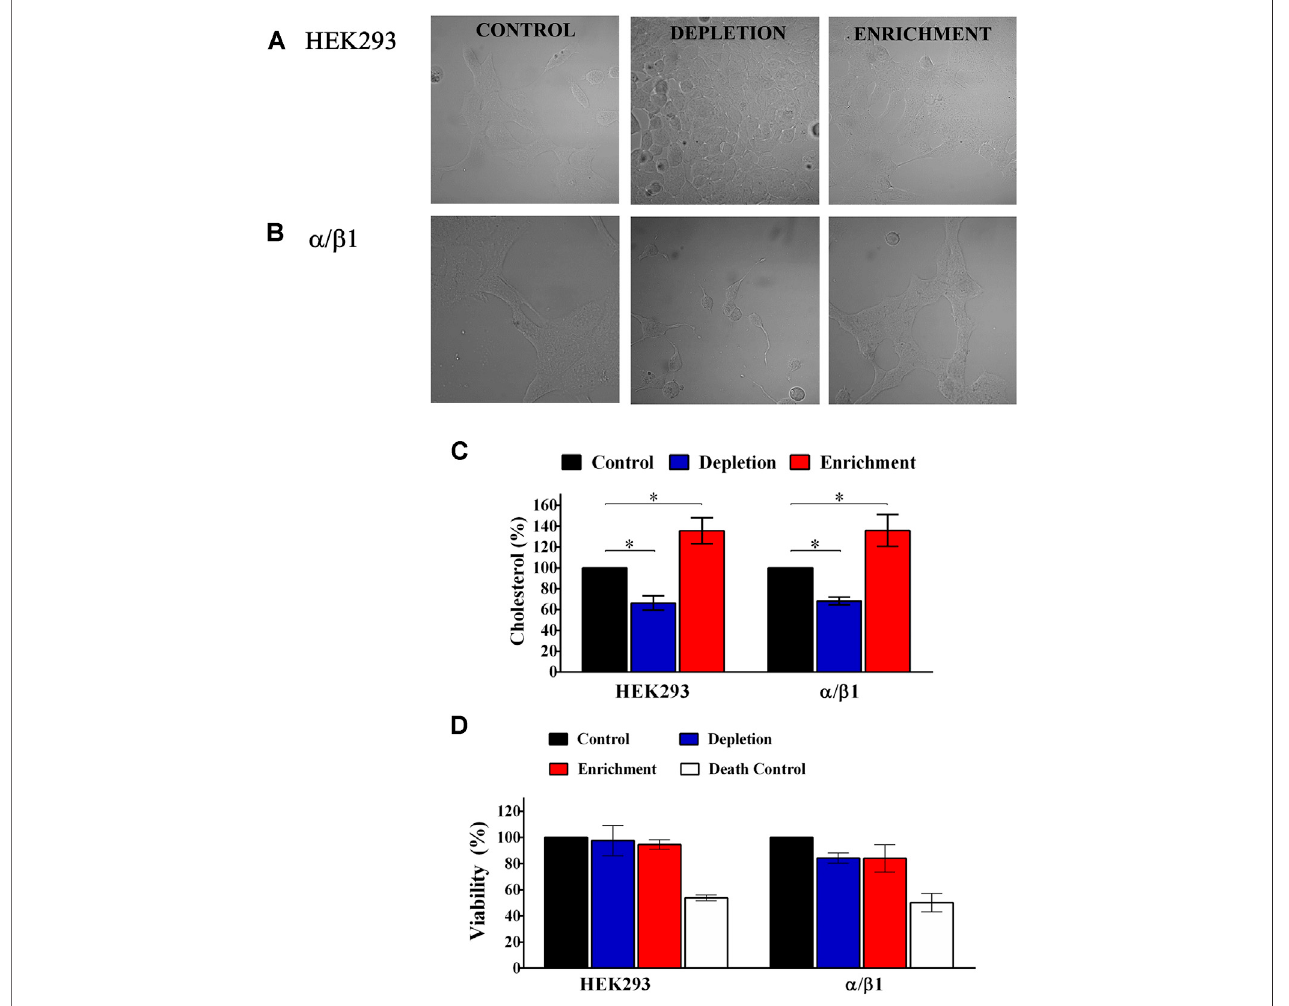
FIGURE 1 | Cholesterol quanti fi cation and cell viability of HEK293 control and cells transfected with BK subunits. (A) HEK293 cells without transfection. (B) HEK293cellstransfected with α + β 1.Leftpanel,controlwithouttreatment.Middlepanel,Cellstreatedwith5 mM ofM β CD.Rightpanel, cellstreatedwith5 mMofCHO- M β CD complex. (C) Results for each treatment with M β CD or M β CD-CLR were normalized using the amount of cholesterol contained in cells without treatment (% of control).Control cell(black bars). HEK293without transfection and HEK293transfected with α / β 1: 100%;Depletedcells (bluebars). HEK293 withouttransfection: 66.3 ± 6.7; α / β 1: 68.2 ± 3.8. Enriched cells (red bars). HEK293: 135.5 ± 12.5; α / β 1: 135.8 ± 15.3. Error bars: SEM. * p < 0.05. n (cid:2) 4. (D) Percentage (%) of viable transfected cells when membrane cholesterol content has been modi fi ed. Control cell (black bars). HEK293 without transfection and HEK293 transfected with α / β 1: 100%; Depleted cells (blue bars). HEK293 without transfection: 97.6 ± 11.6; α / β 1: 84.2 ± 4. Enriched cells (red bars). HEK293: 94.7 ± 3.7; α / β 1: 84 ± 10.5. White bars Death Control represent death cells control with rotenone 50 – 56%. Error bars: SEM. n (cid:2)